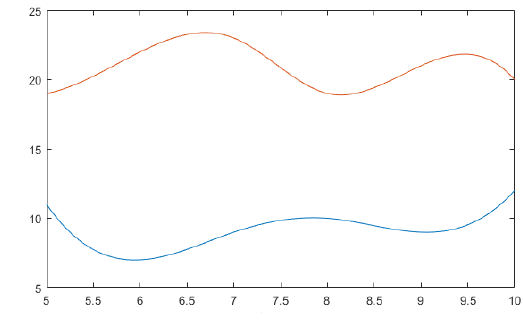
Figure 7. The influence of multipath